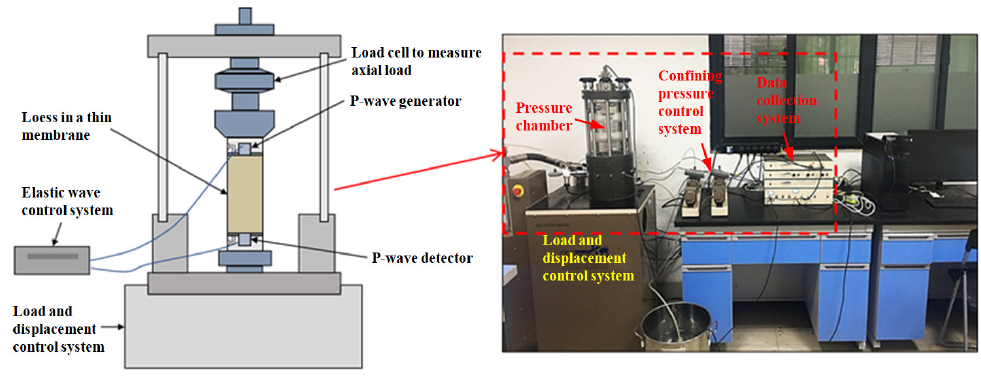
Figure 3. GDS triaxial test system.